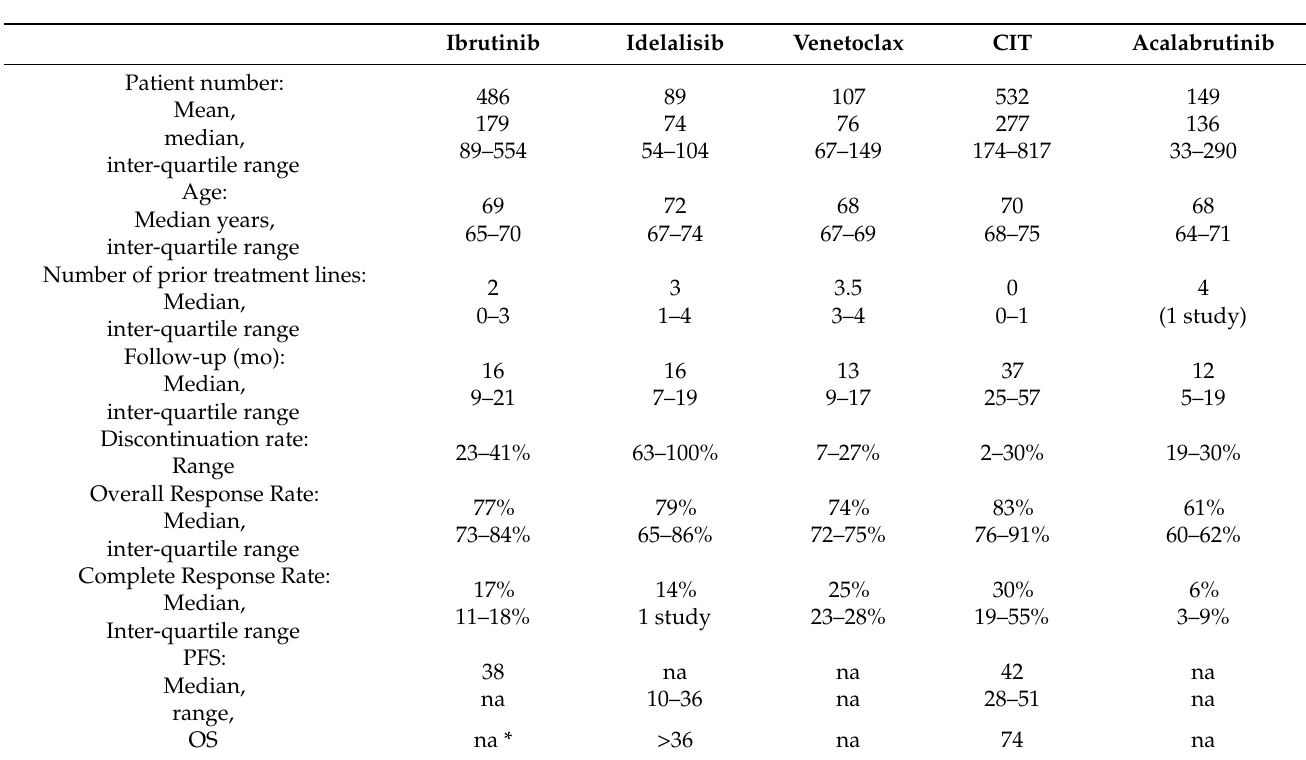
Table 4. Patient